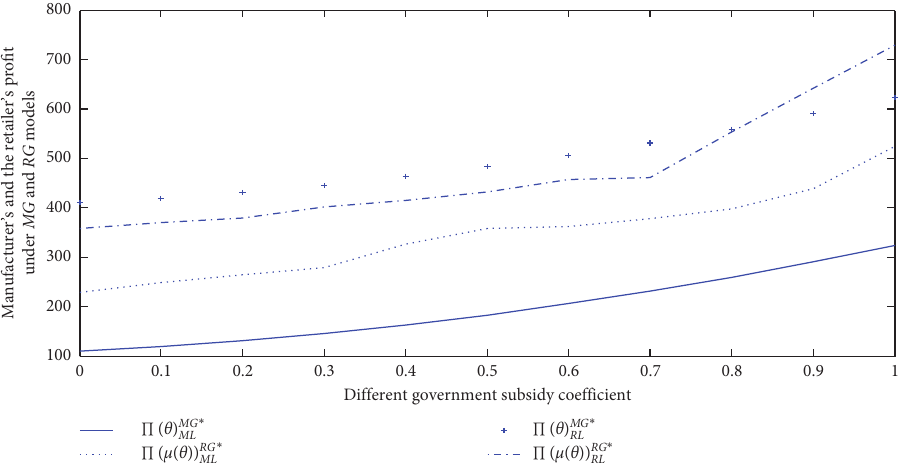
Figure 6: The impact of different government subsidy coefficients on the enterprise’s profit when the selling effort level is